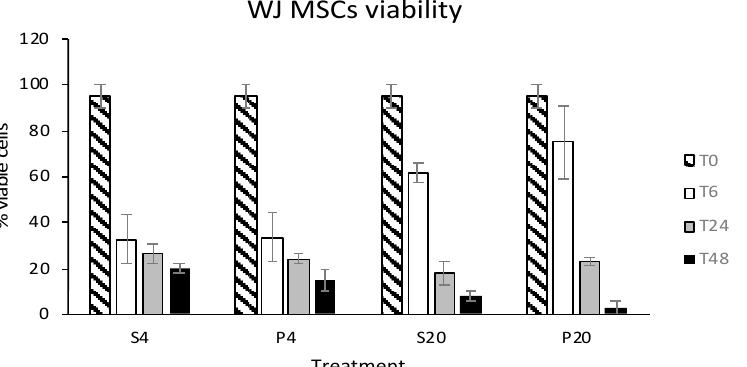
6 of 14 Figure 1. eATMSCs viability after storage for 6 (T6), 24 (T24) and 48 (T48) hrs in saline solution (S) and plasma (P) at 4 °C (4) and room temperature (20): a vs. b; c vs. d; e vs. f: p < 0.05. Data regarding eWJMSCs viability after storage are shown in Figure 2. Different from